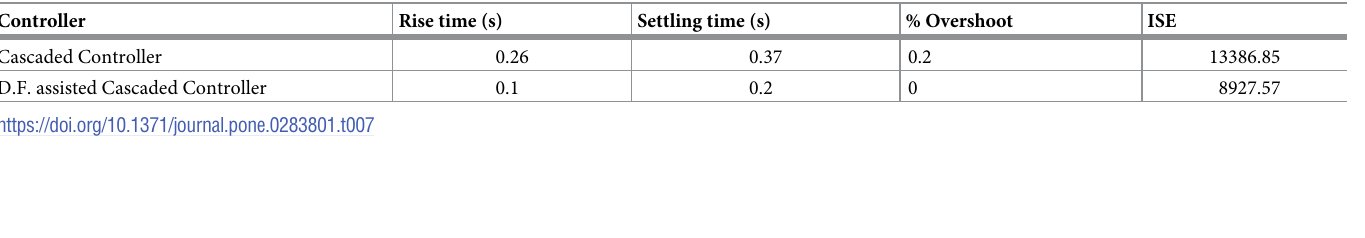
Table 7. Stability analysis of pressure system with ISE objective